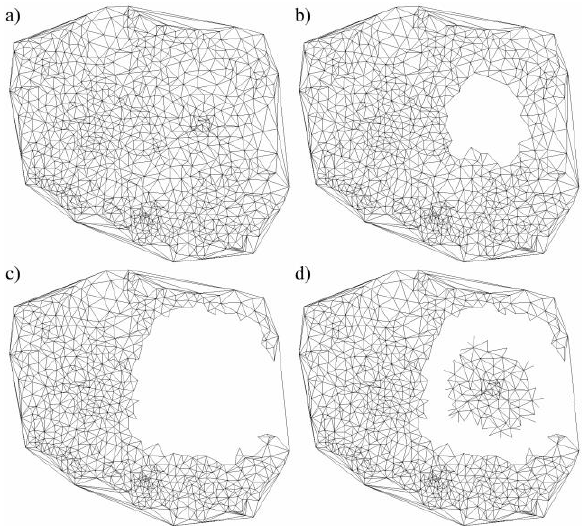
Figure 6. TIN model: a) original; b) 250 edges removed; c)